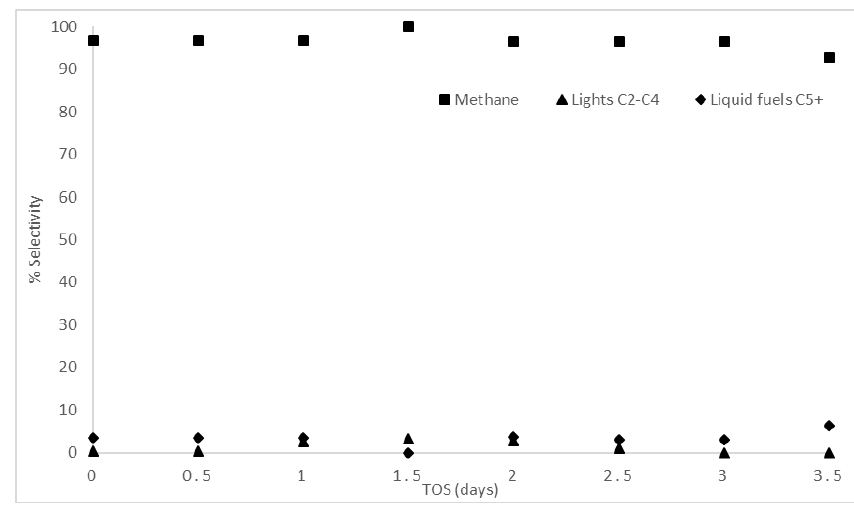
Figure 2. CO conversion for R1, R2, and R3 (refer to Tables 1 and 2 for reaction details).